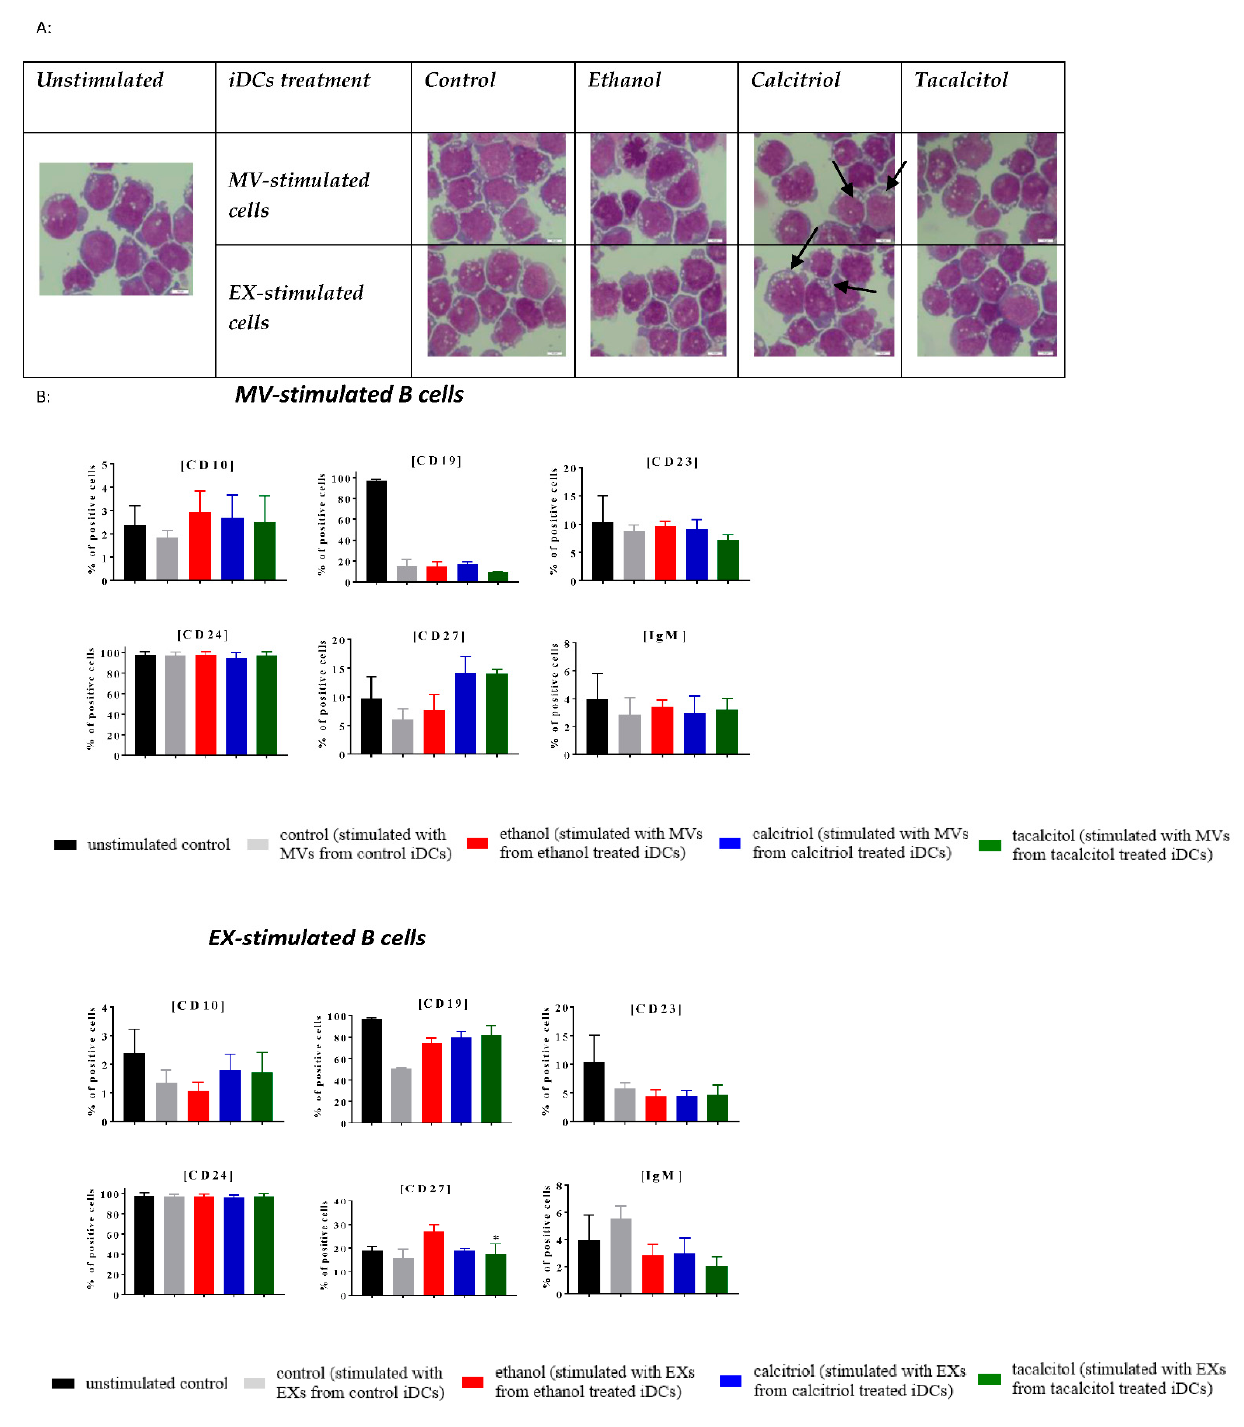
Figure 10. The indirect effects of calcitriol and tacalcitol on RCH-ACV cell line after 24 h stimulation with EVs derived from iDCs: ( A ) morphology of EV-stimulated RCH-ACV cell line; scale bar 10 μ m. Each staining was performed twice; Black arrows indicate vacuolization in cells. ( B ) distribution of differentiation markers by flow cytometry analysis. Mean values and standard deviation are presented. Statistical analysis: Sidak’s multiple comparison tests in comparison with ethanol were performed; significant differences as compared with ethanol (* p < 0.005). Each experiment was performed at least 3 times.